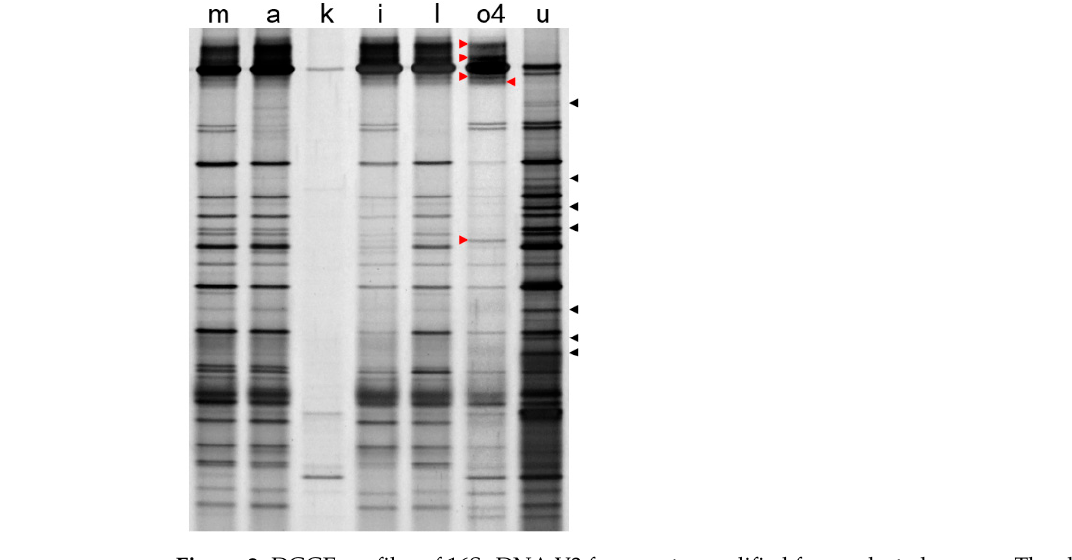
Figure 2. DGGE profiles of 16S rDNA V3 fragments amplified from selected groups. The characters on top of each lane indicated the groups described in Table 1 except for group u, in which the DNA template representing epiphytes was extracted from the remaining seawater left by group o4. Red arrows indicated partial specific bands from potential endo-bacteria which were absent in group u. Black arrows indicated partial specific bands from potential epi-bacteria which were absent in group o4.